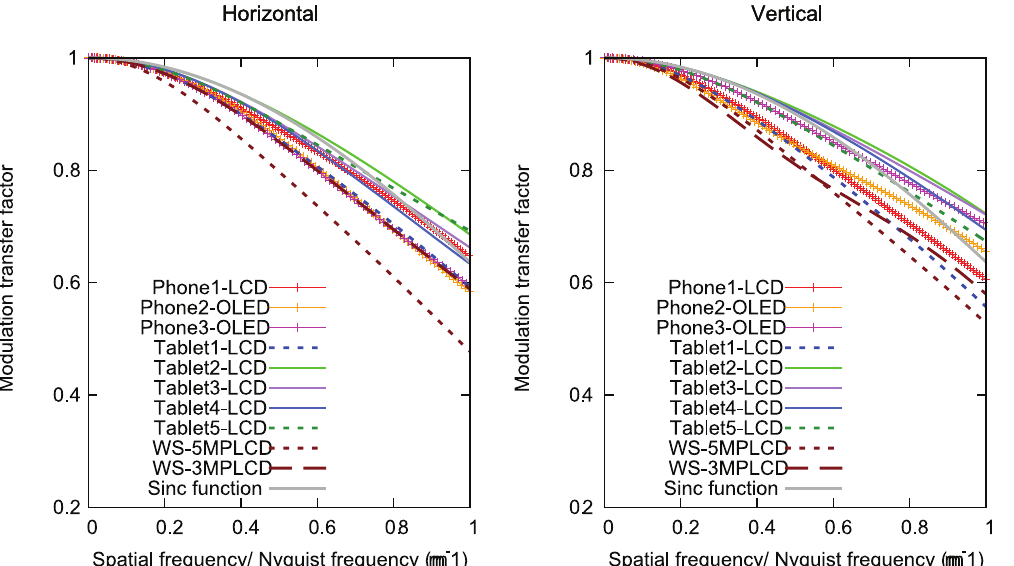
Figure 6. Modulation transfer functions as a function of relative spatial frequency for the devices tested in this study. Sinc function representing the ideal MTF is included.